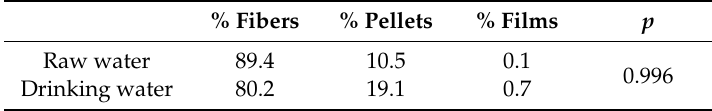
Table 1. Particle shapes in raw and drinking water of the Sinos River